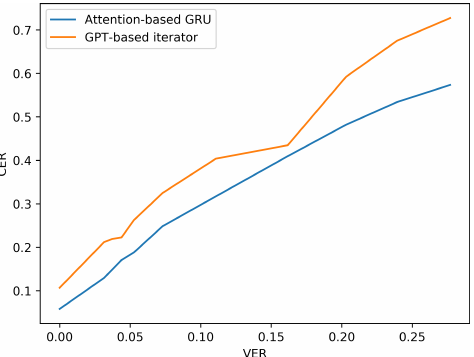
Figure 10. CER performance under varying noise levels (evaluation on LRS2 corpus).